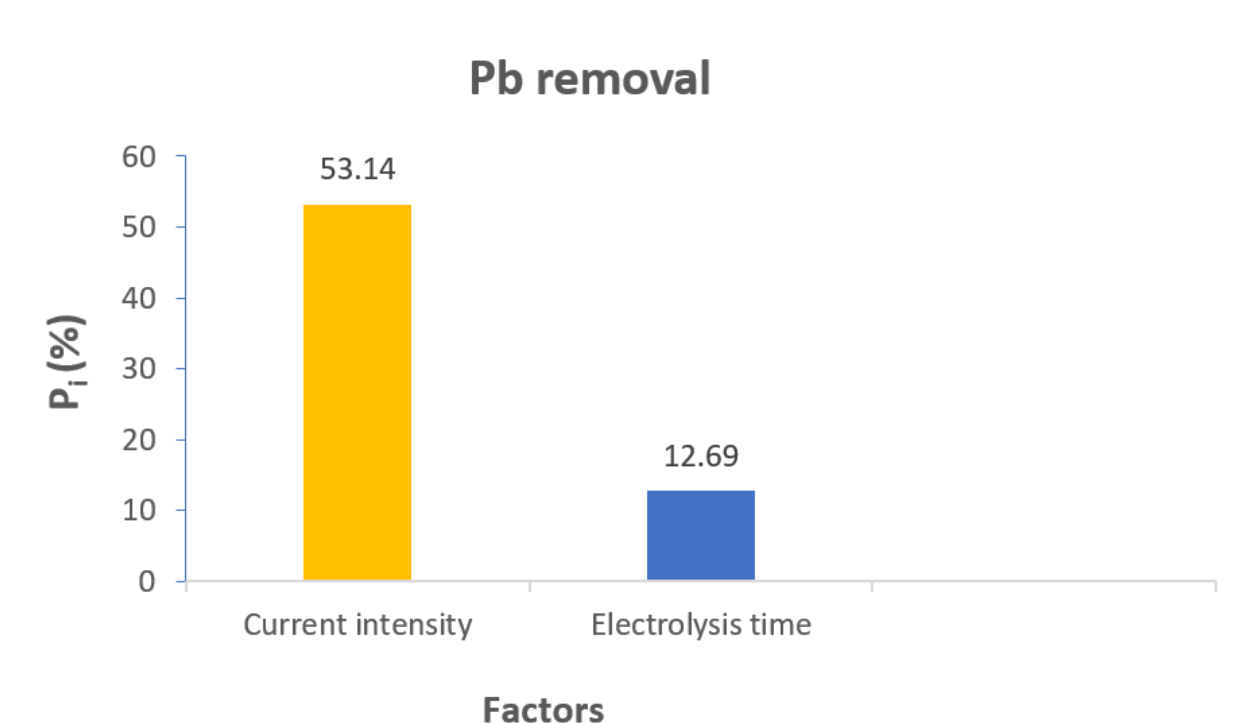
Figure 3. Pareto analysis of the effects of factors on Pb removal for DO concentrate treatment by the PA-ECF technique.